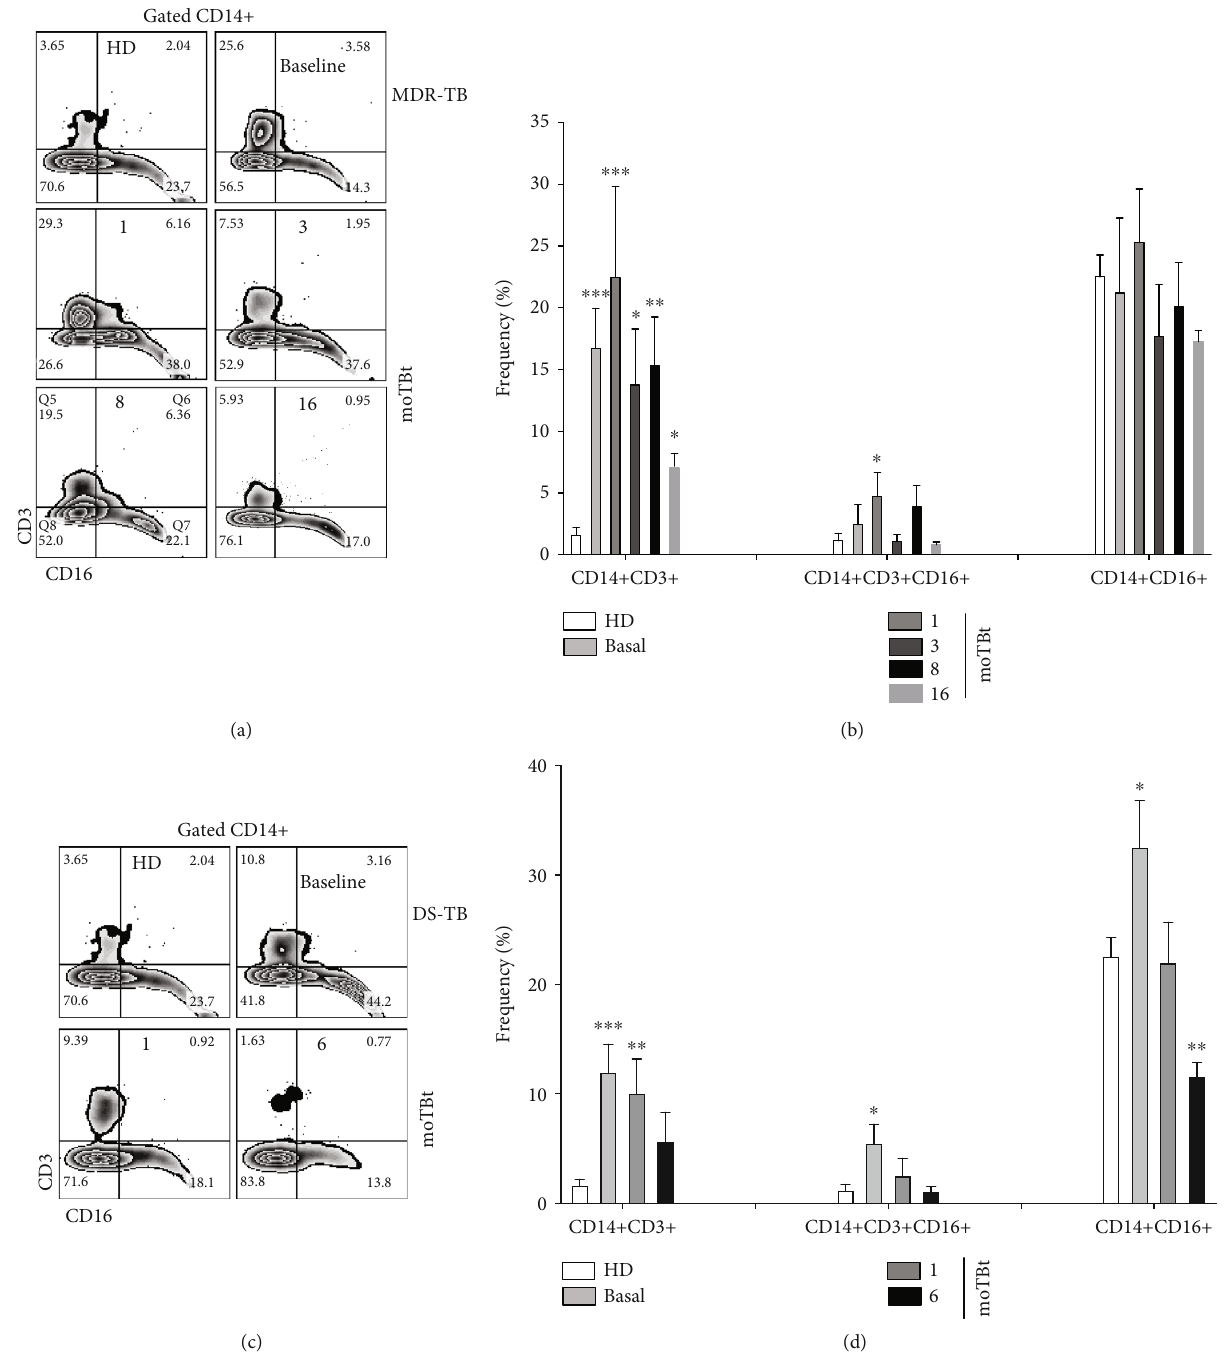
Figure 2: Increased frequency of CD14+CD3+ monocytes during DS-TB and MDR-TB. Representative zebra plots illustrating the gating strategy used to analyze CD3 and CD16 expressions in total CD14+ cells. Peripheral blood mononuclear cells (PBMCs) from multidrug- resistant tuberculosis (MDR-TB) and drug-sensitive tuberculosis (DS-TB) patients were obtained at di ff erent time points and employed for phenotypical characterization by fl ow cytometry (a and c, respectively). (b) Frequency of CD14+CD3+, CD14+CD3+CD16+, and CD14+CD16+ subpopulations in MDR-TB patients (HD: n = 6 ; MDR-TB: baseline and 1 and 3 moTBt n = 10 , 8 moTBt n = 8 , 16 moTBt n = 7 ) (d) Frequency of CD14+CD3+, CD14+CD3+CD16+, and CD14+CD16+ subpopulations in DS-TB patients (HD: n = 6 ; DS-TB: baseline and 1 moTBt n = 10 , 6 moTBt n = 8 ). Bar graphs show means ± standard errorof the mean ð SEM Þ . Di ff erences between patient groups and HD at each time point were analyzed using multiple Student ’ s t -test corrected for multiple comparisons using the Sidak